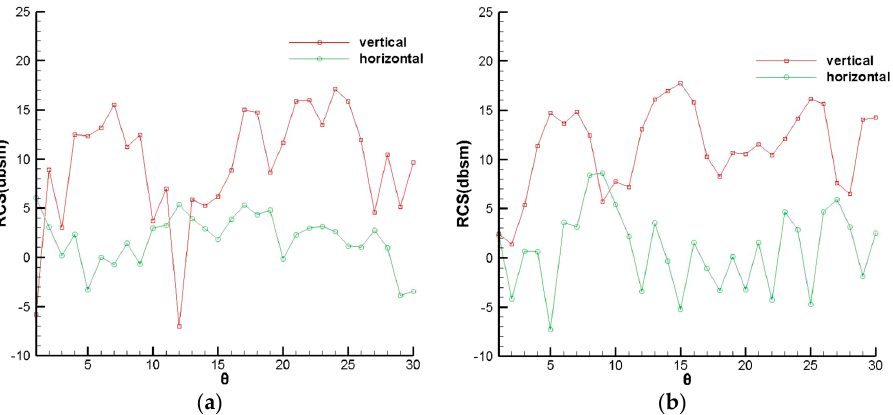
Figure 9. RCS calculation results of model S. ( a ) Horizontal polarization ( b ) Vertical polarization. Table 6. Average RCS values of three